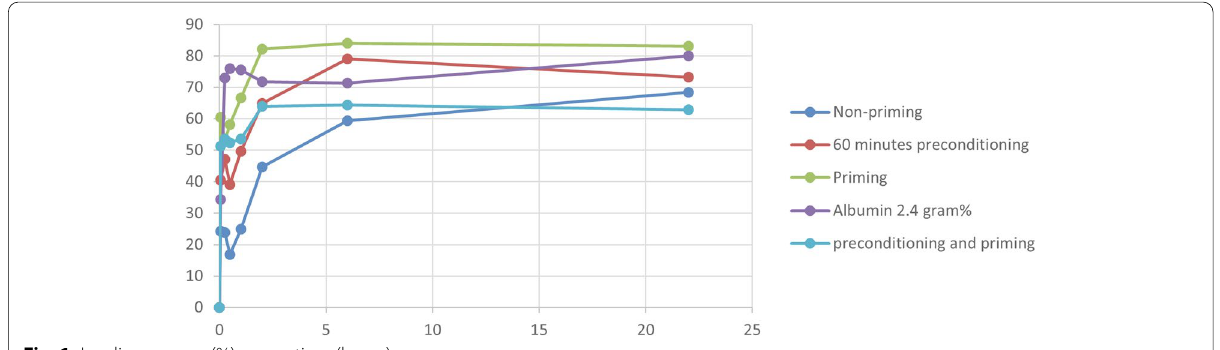
Fig. 1 Insulin recovery (%) versus time